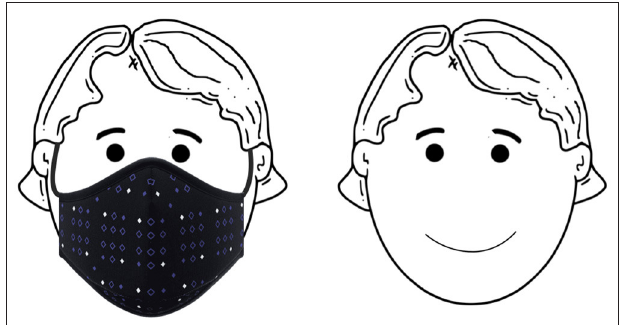
FIGURE 2 | Face-masked and non-face-masked images used as visual information about the speaker.